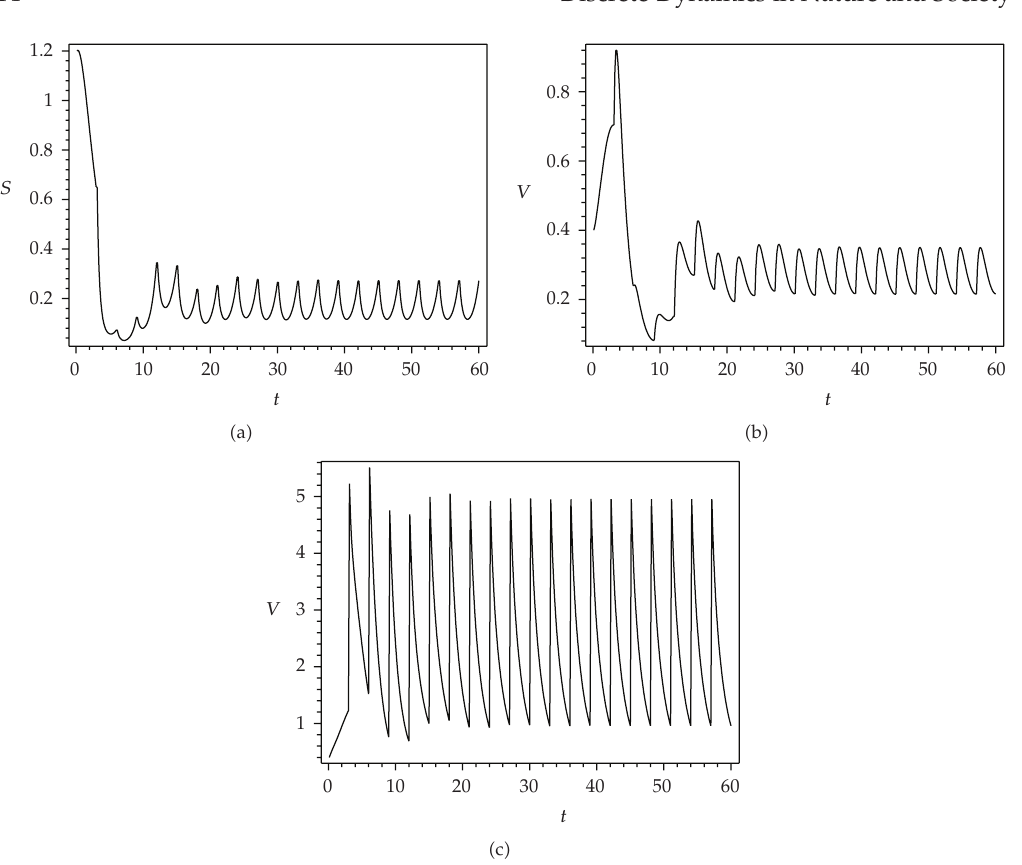
Figure 2: Dynamical behavior of the system (cid:4) 1.1 (cid:5) with r (cid:7) 1 . 8 ,K (cid:7) 2 ,θ (cid:7) 0 . 6 ,β (cid:7) 0 . 2 ,p (cid:7) 4 ,λ (cid:7) 0 . 8 ,μ (cid:7) 0 . 8 ,b (cid:7) 3, and T (cid:7) 3